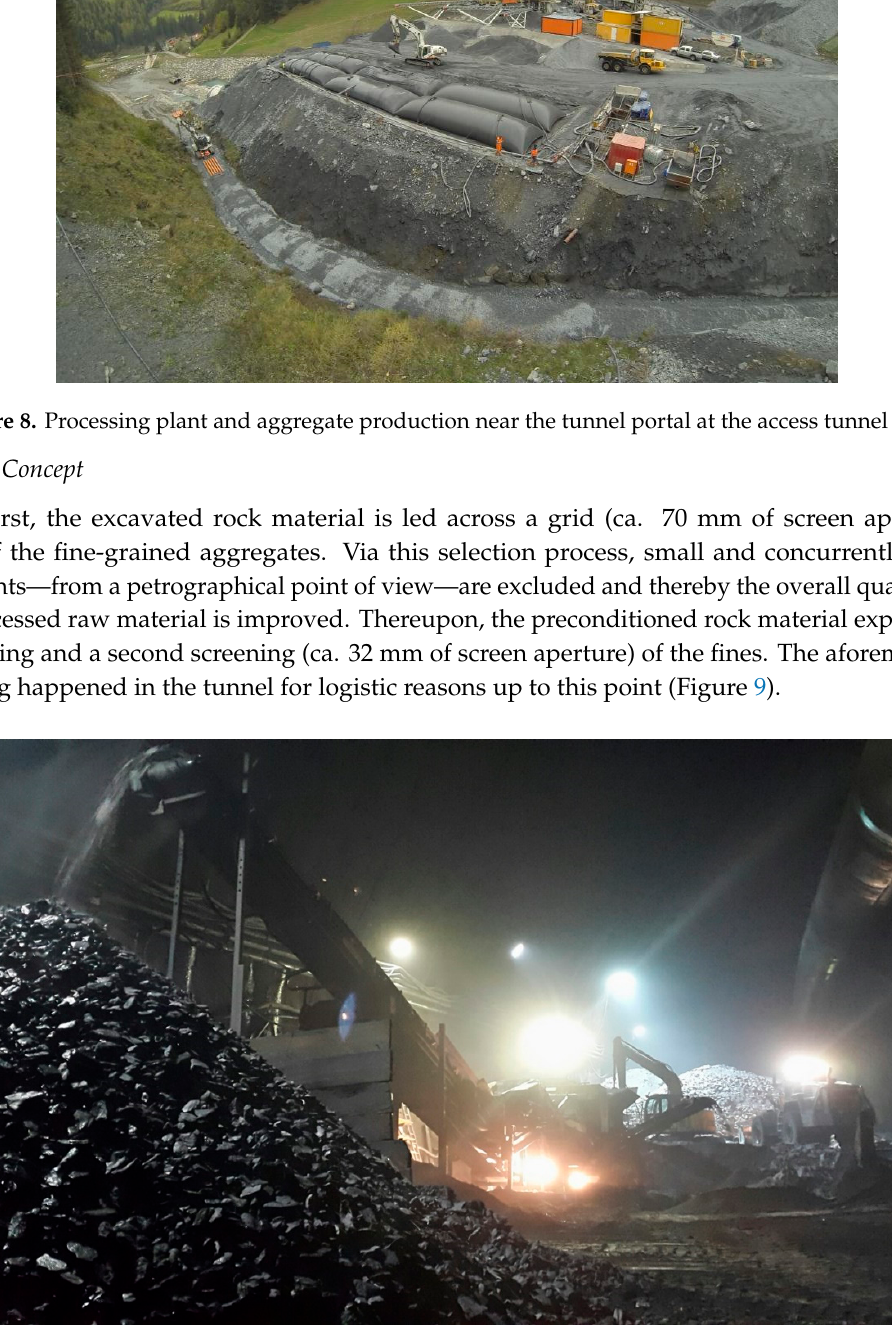
Figure 9. Processing plant and aggregate production in the access tunnel Wolf (compare Figure 3).